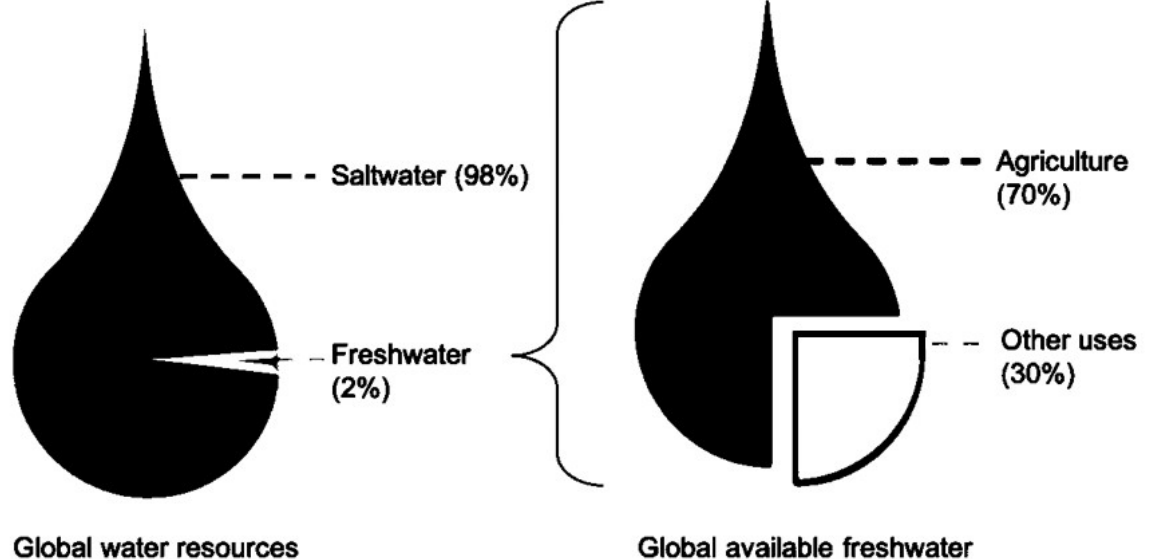
Figure 7. Schematic impression of global freshwater scarcity and the freshwater demand for agri- culture already being at a very high level (adapted from [95–101]).